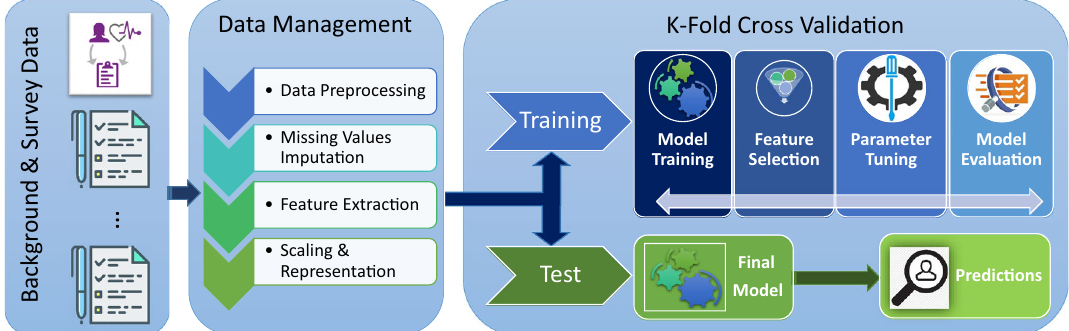
Figure 7. Study workflow and analytical strategy. Data were obtained from the “Biology, Affect, Stress, Imaging and Cognition during Pregnancy and the Puerperium” (BASIC) study, a population-based prospective cohort study in Uppsala, Sweden. Data included in our study comprised (i) background, medical history and pregnancy-related variables (BP) from women, and (ii) further psychometric questionnaires, available at discharge from the delivery ward. The data were processed and either were used to test models or train the machine learning algorithms, to predict depressive symptoms at 6 weeks